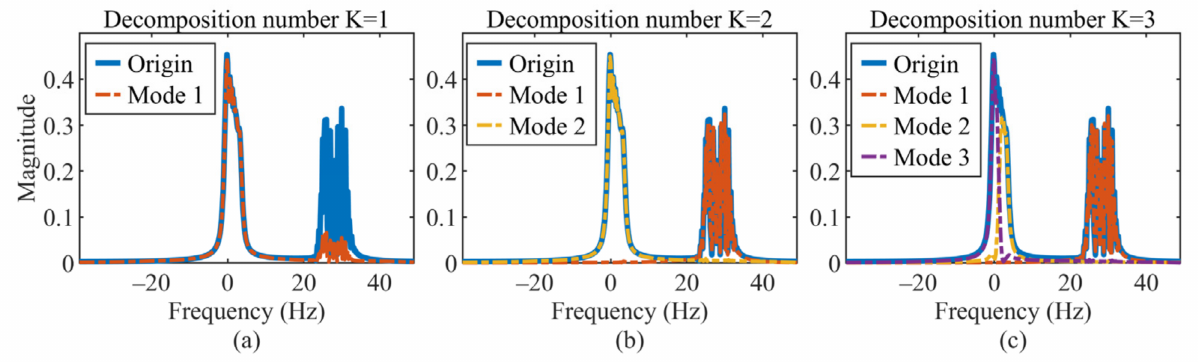
Figure 7. Spectrum of the original signal (blue solid line) and the decomposed modes (dotted line): ( a ) decomposition number K = 1, ( b ) decomposition number K = 2, and ( c ) decomposition number K = 3.